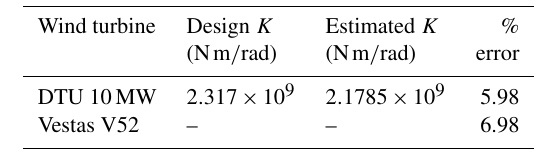
Table 1. Comparison of estimated K with design K for a turbine variant where only the main shaft is flexible.